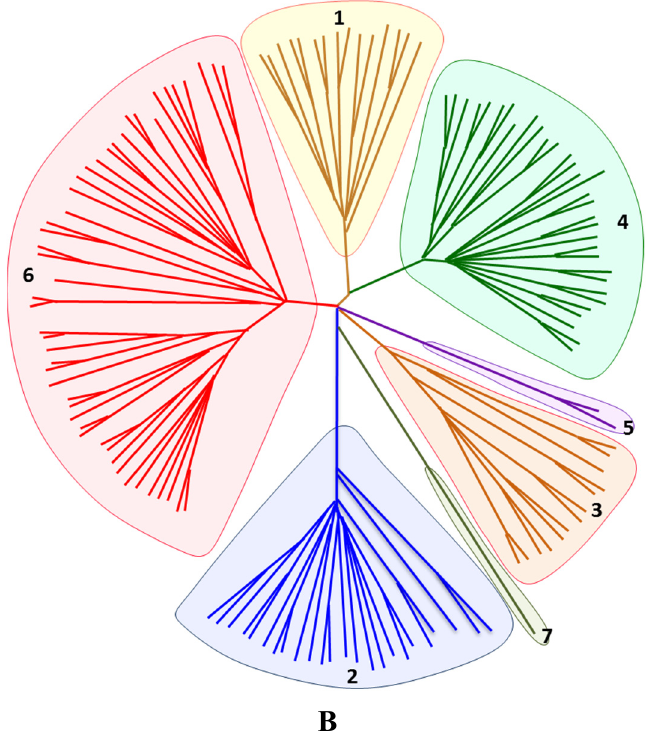
Figure 1. HCV genome organization and genotypes. ( A ) HCV genome organization is shown. The most common regions used for molecular analyses and genetic relatedness studies are highlighted; ( B ) HCV representative strains belonging to all seven genotypes and all different subtypes are depicted. Sequences from the NS5B region were chosen to illustrate the maximum diversity within a subtype. The neighbor joining tree was constructed using maximum composite likelihood nucleotide distances using MEGA5 and 1000 replications for